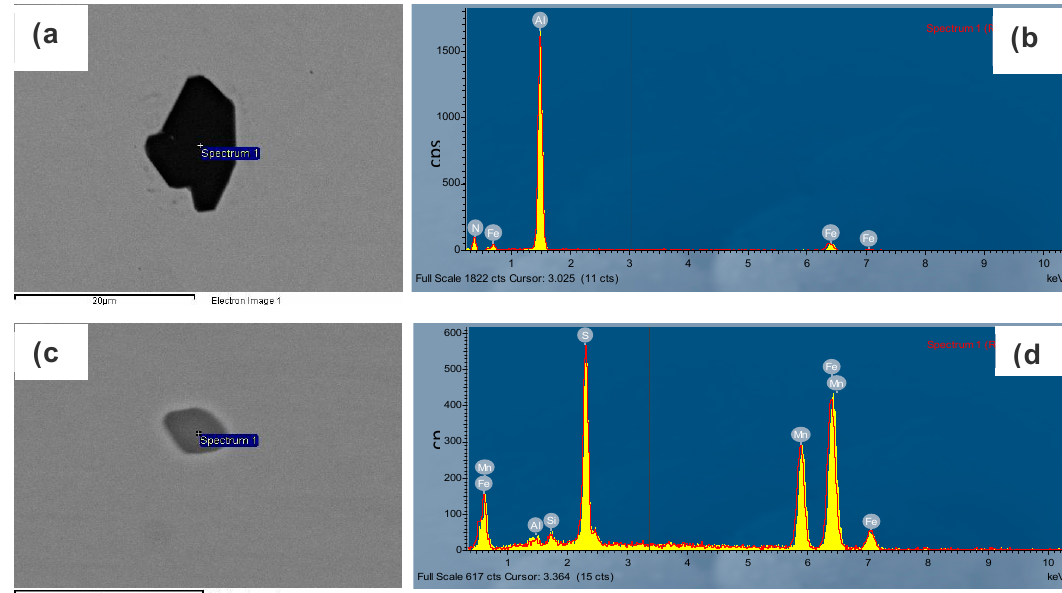
Figure 7. Micrographs of SEM and energy-dispersive X-ray (EDX) spectra of the inclusions present in the steel in casting condition. ( a ) AlN, ( c ) MnS, and ( b , d ) EDX spectra of inclusions.